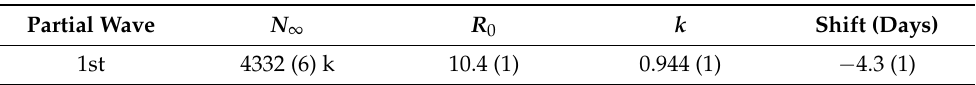
Table 4. The parameters of the Gompertz curve for the o surge in Japan. The definition of the parameters is the same as in Table 3, but the reference date is 1 January 2022.